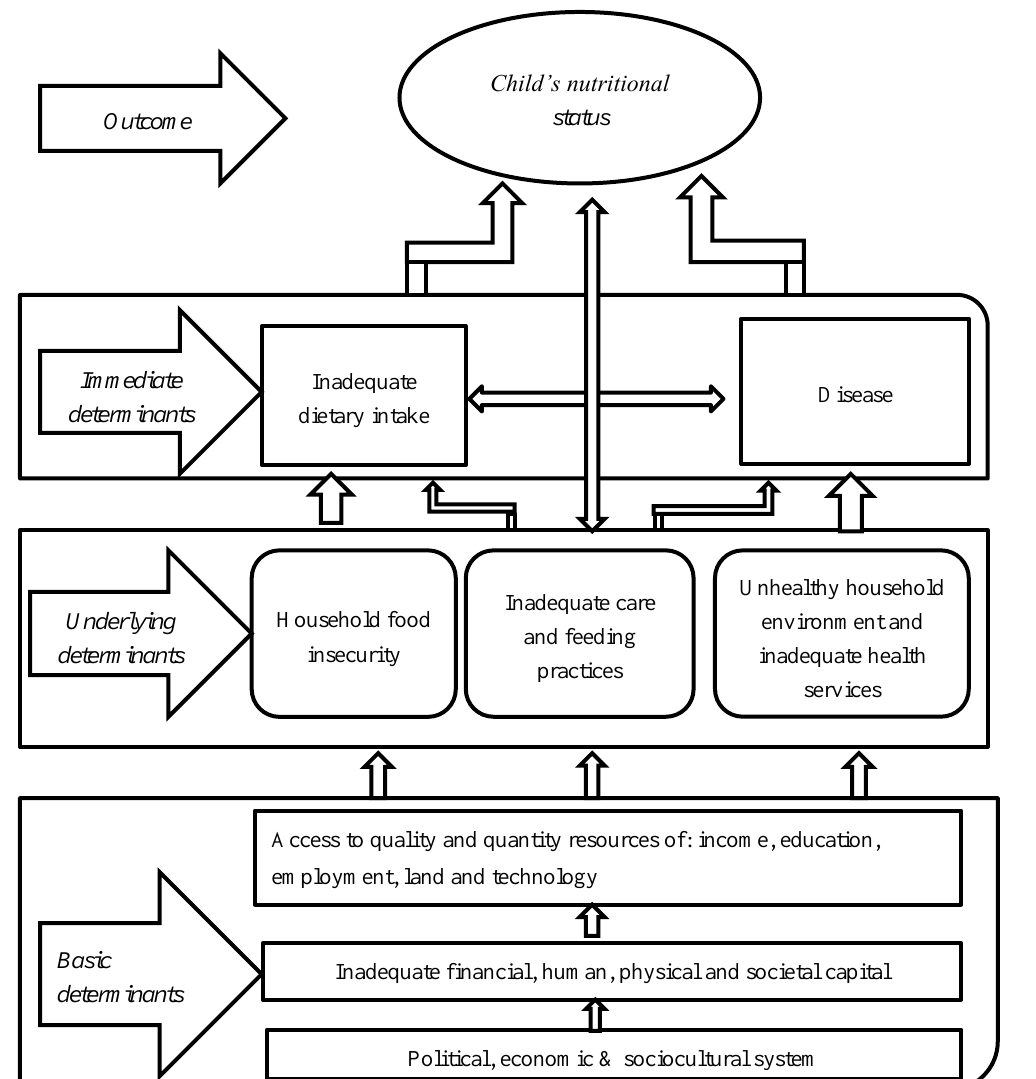
Figure 1Conceptual Framework: The Determinants of Child Nutritional Status 168 Figure 1. Conceptual framework: the determinants of child nutritional status. Source: Adapted from UNICEF 1998, 2015